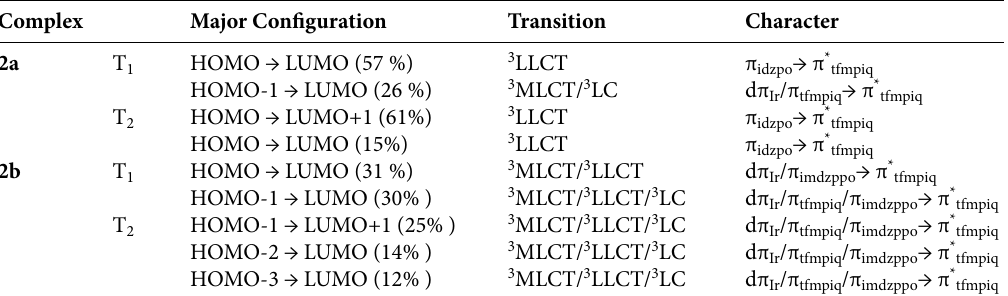
Table 6. Contribution of triplet transitions and transition characters for complexes 2a – 2b .